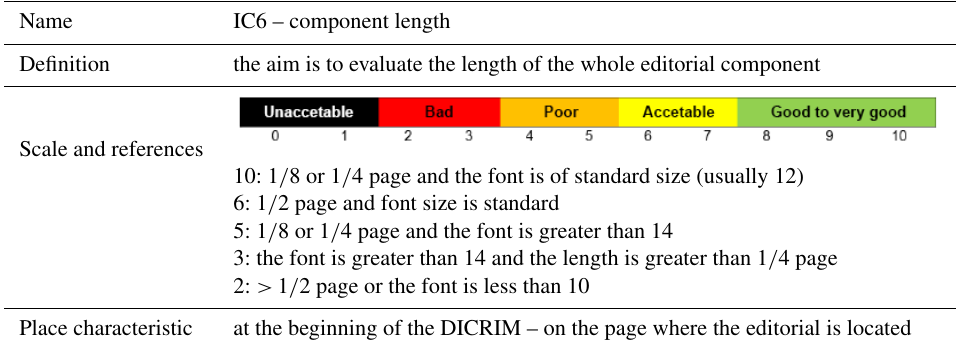
Table 8. Example of an indicator grid for evaluating the length of the editorial